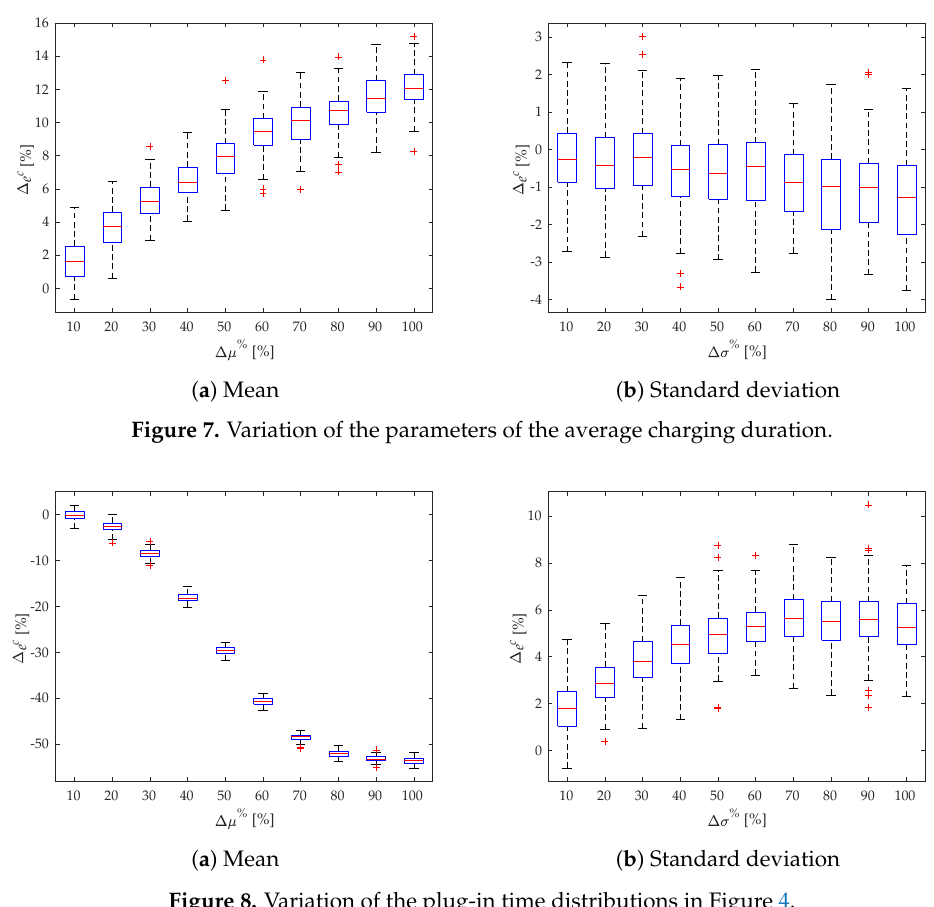
Figure 8. Variation of the plug-in time distributions in Figure 4.